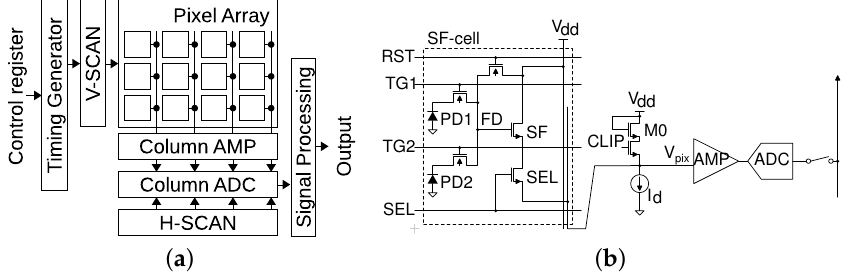
Figure 2. Block diagram of the CIS and a column readout circuit. ( a ) Chip overview. ( b ) Column readout circuit.